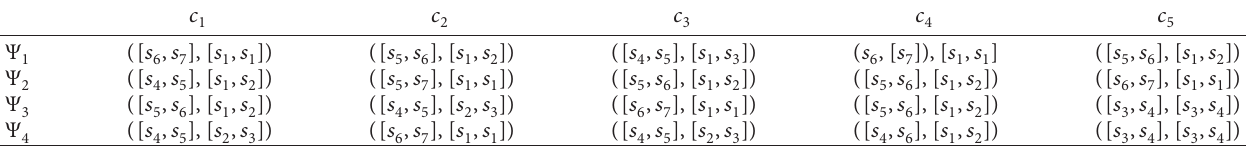
Table 8: Decision matrix R .